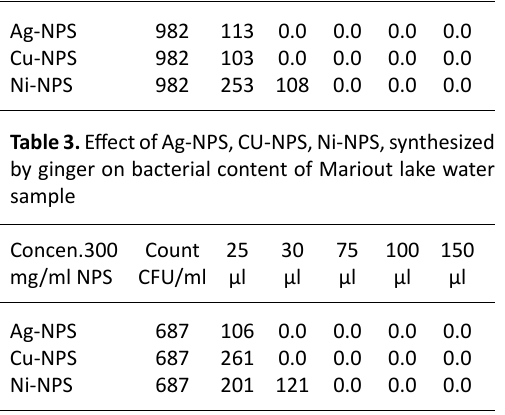
table 2. Effect of Ag-NPS, CU-NPS, Ni-NPS, synthesized by ginger on bacterial content of El Kilo21 lake water sample Concen. 300 Count